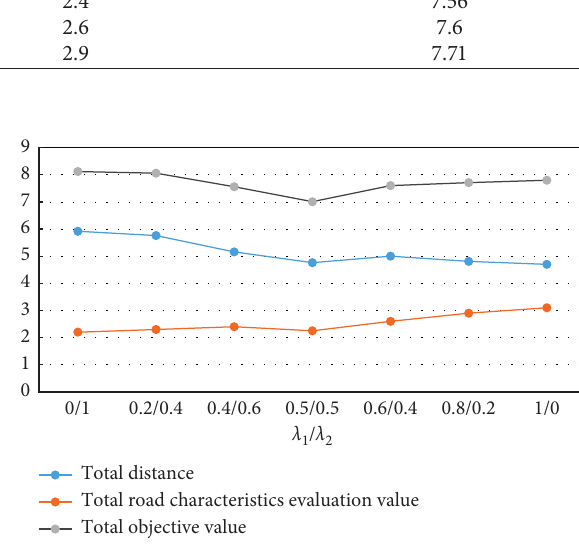
Figure 9: The results under all